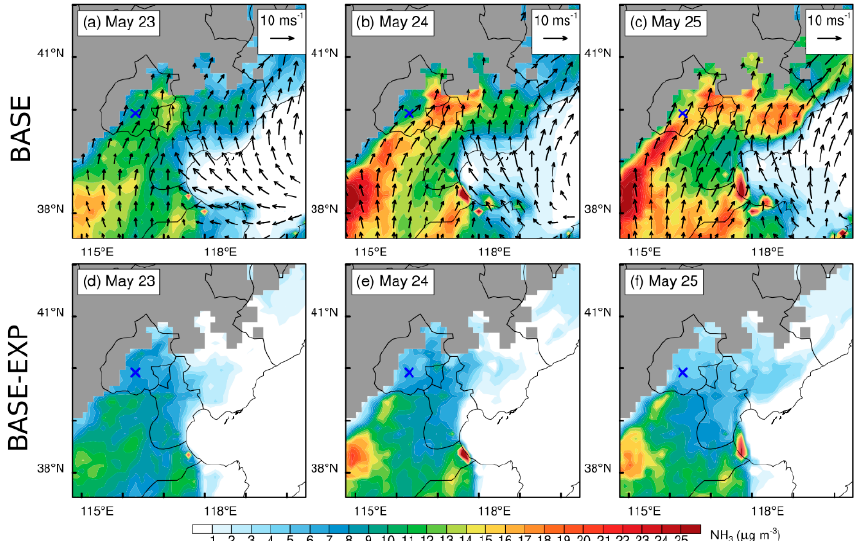
Figure 7. Spatial distribution of the simulated near-surface NH 3 concentrations and winds at 18:00 LT on ( a , d ) 23 May, ( b , e ) 24 May, and ( c,f ) 25 May, 2015. The mountainous regions are denoted by the grey shadings. The top panels show the simulation results of the baseline (BASE) run, and the bottom panels present the differences between the BASE run and sensitivity experiment (EXP). The location of the NH 3 monitoring site in Beijing is indicated by the blue cross.